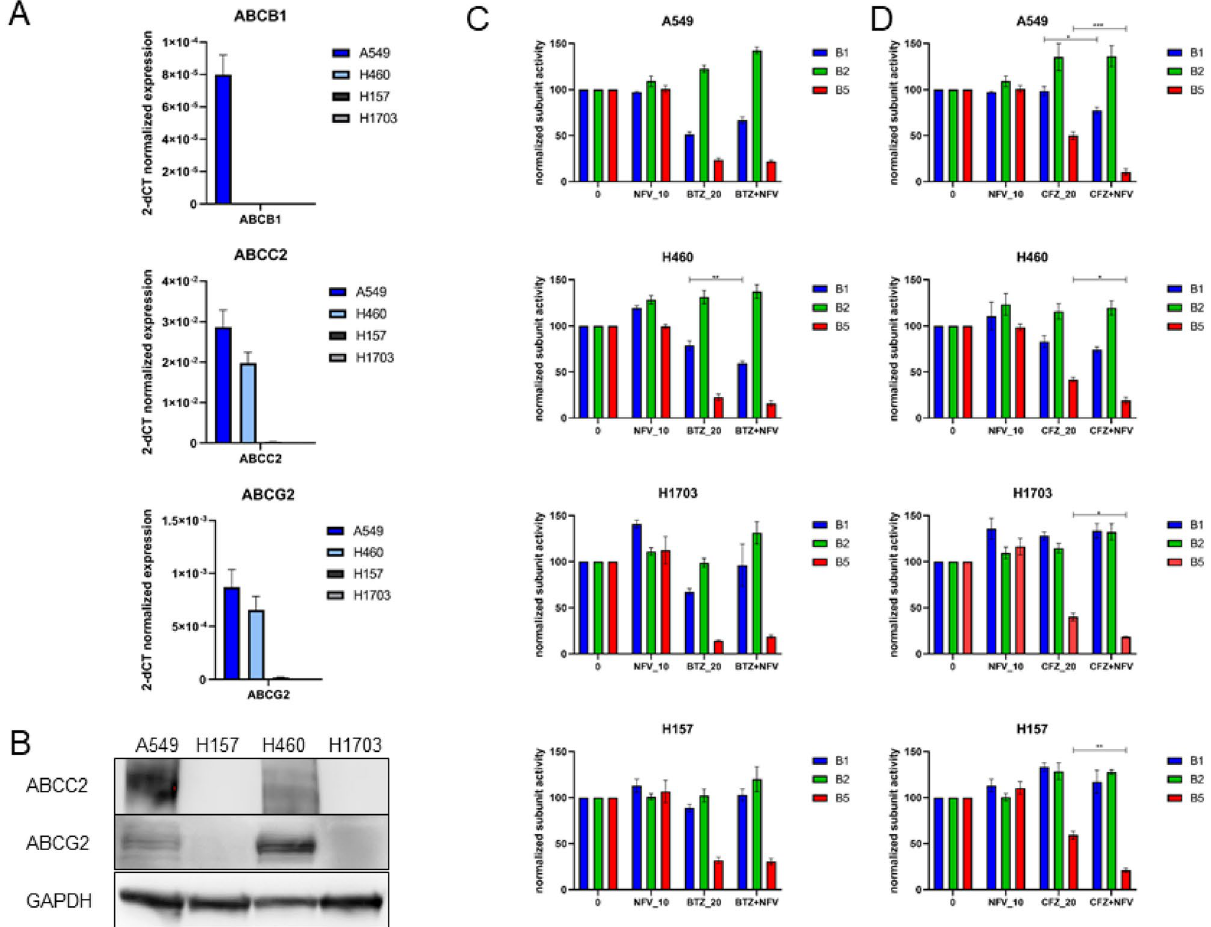
Figure 5. Efflux pumps and their involvement in the intracellular availability of carfilzomib in NSCLC cell lines. ( A ) Expression of ATP-type transporters ABCB1, ABCC2 and ABCG2 in A549, H157, H460 and H1703 cell lines as determined by quantitative real-time PCR. Data are normalized to GAPDH, expressed in 2 −dCt values and are presented as the mean ± SD of at least 3 replicates. ( B ) Levels of ATP-type transporters ABCC2 and ABCG2 in the same cell lines determined by western blot. Data show a representative blot of 3 replicates. ( C , D ) Active site labeling with proteasome subunit-selective probes was performed after ( C ) bortezomib or ( D ) carfilzomib pulse treatment (both drugs 10 nM and 20 nM) alone or in combination with nelfinavir (20 µM for A549; 10 µM for H460, H157 and H1703) for 1 h in NSCLC cell lines. Proteasome subunit activities are illustrated in different colors as follows: β1 in blue, β2 in green and β5 in red. Data represent the mean ± SD of at least two replicates. The original data are presented in Fig. S3. * Represents p < 0.05; ** represents p < 0.01; *** represents p <